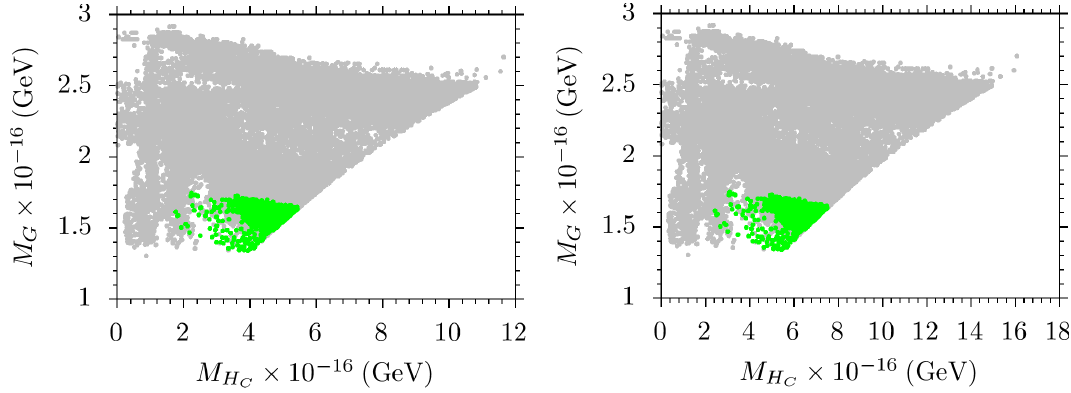
Figure 3 . Allowed parameter space in the M G − M H plane in SUSY SU(5) with threshold effects C causing smearing of the unified gauge coupling (left panel) and from the Σ 4 superpotential corrections (right panel). All points are compatible with the REWSB and the LSP being a neutralino. Green points show the allowed region from the Higgs boson mass, B -physics constraints and LHC limits on SUSY